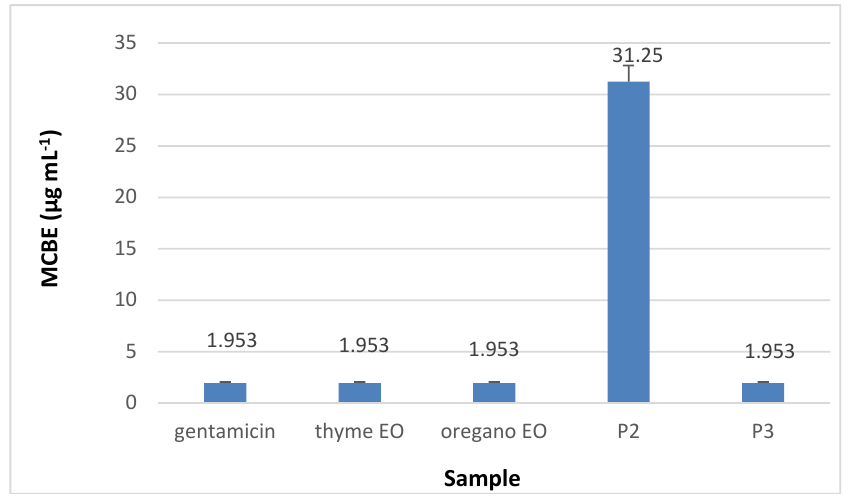
Figure 14. Minimal concentration for biofilm eradication (MCBE) of collagen nanofibres loaded with essential oils against S. aureus ATCC 25923, as compared to gentamicin and essential oils.